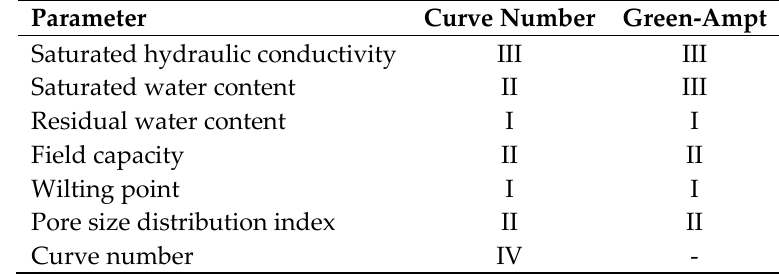
Table 3. Sensitivity analysis class of infiltration computed with Curve Number and Green-Ampt equations.